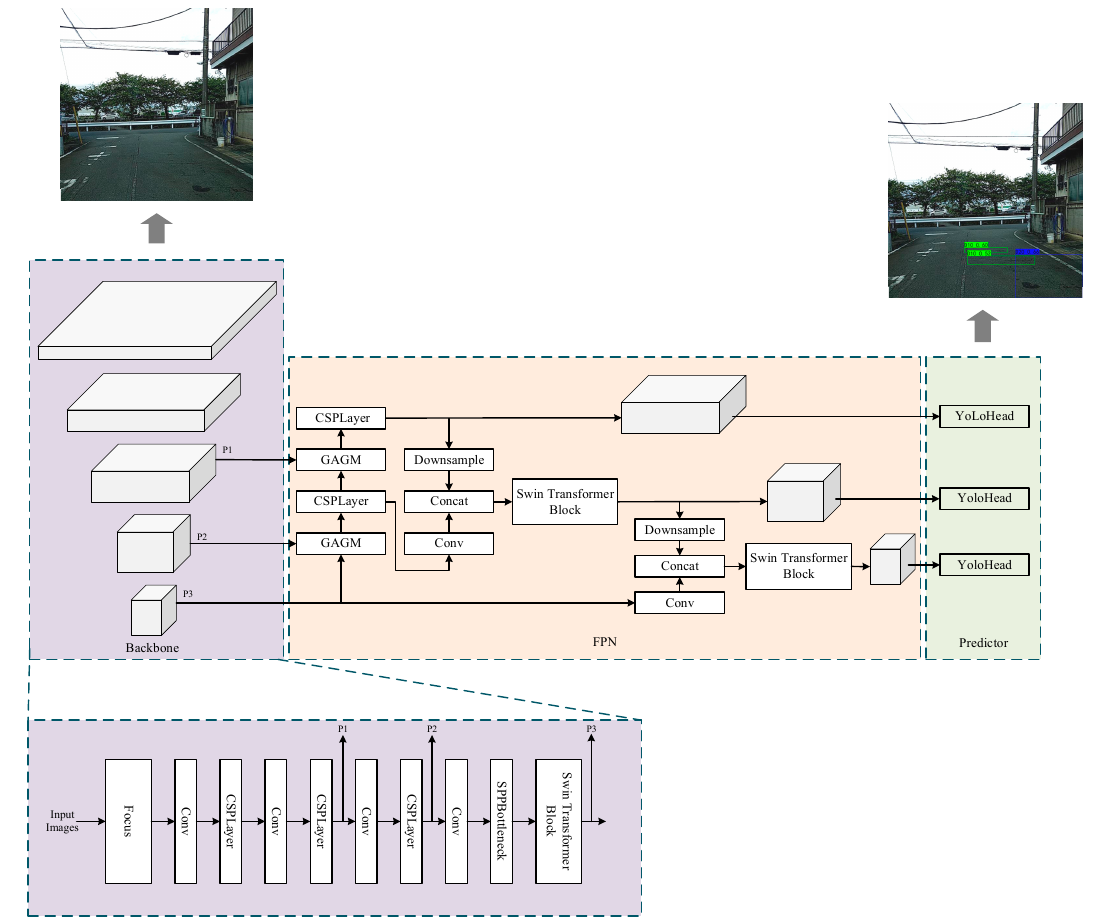
Figure 2. The architecture of STrans-YOLOX.